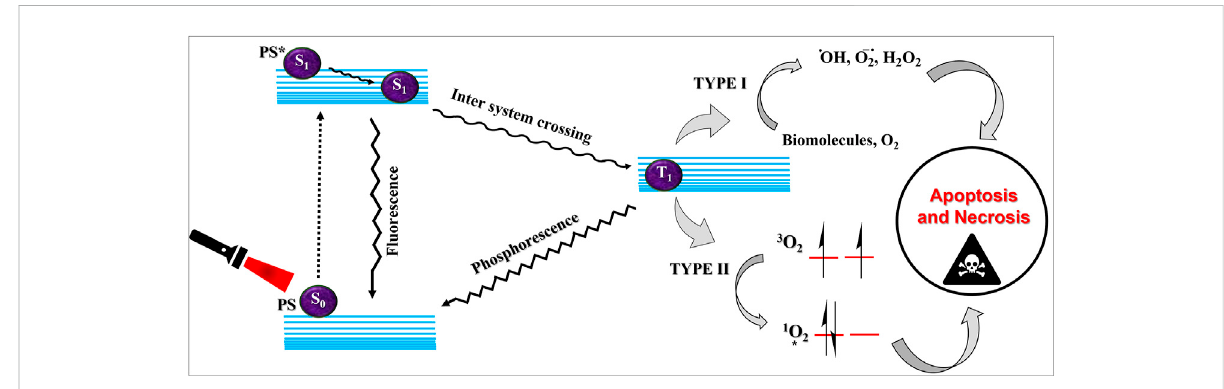
FIGURE 1 Schematic explanation of photodynamic therapy. The ground state photosensitizer (S0) on suitable irradiation, gets excited to the singlet state (S1).ThissingletstatePScan fl uorescebacktothegroundstateorcanconverttothetripletexcitedstate(T1)viaintersystemcrossing.Thetripletstate can transfer energy via type I or type II processes leading to the generation of reactive oxygen species and execution of photodynamic therapeutic